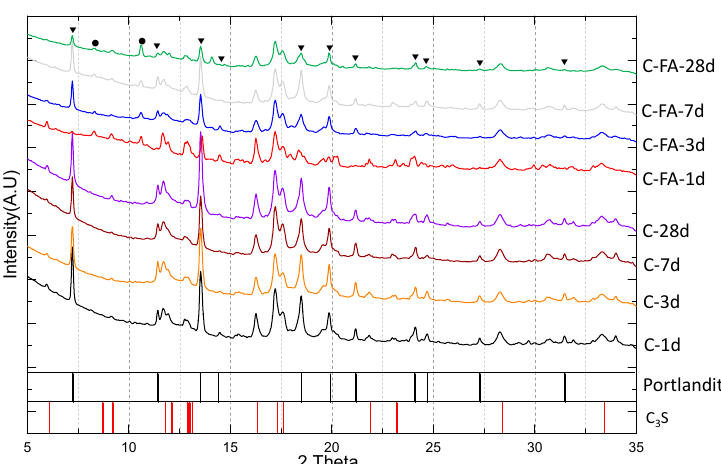
Figure 1. Synchrotron powder X-ray diffraction patterns for C 3 S (C) and C 3 S substituted 50% by fly ash (C-FA) pastes. ● : Quar tz , ▼ : Portlandite (Ca(OH) 2 ). Relative intensities above 5% were classified using the ICDD PDF2 database reference 00-087-0674.